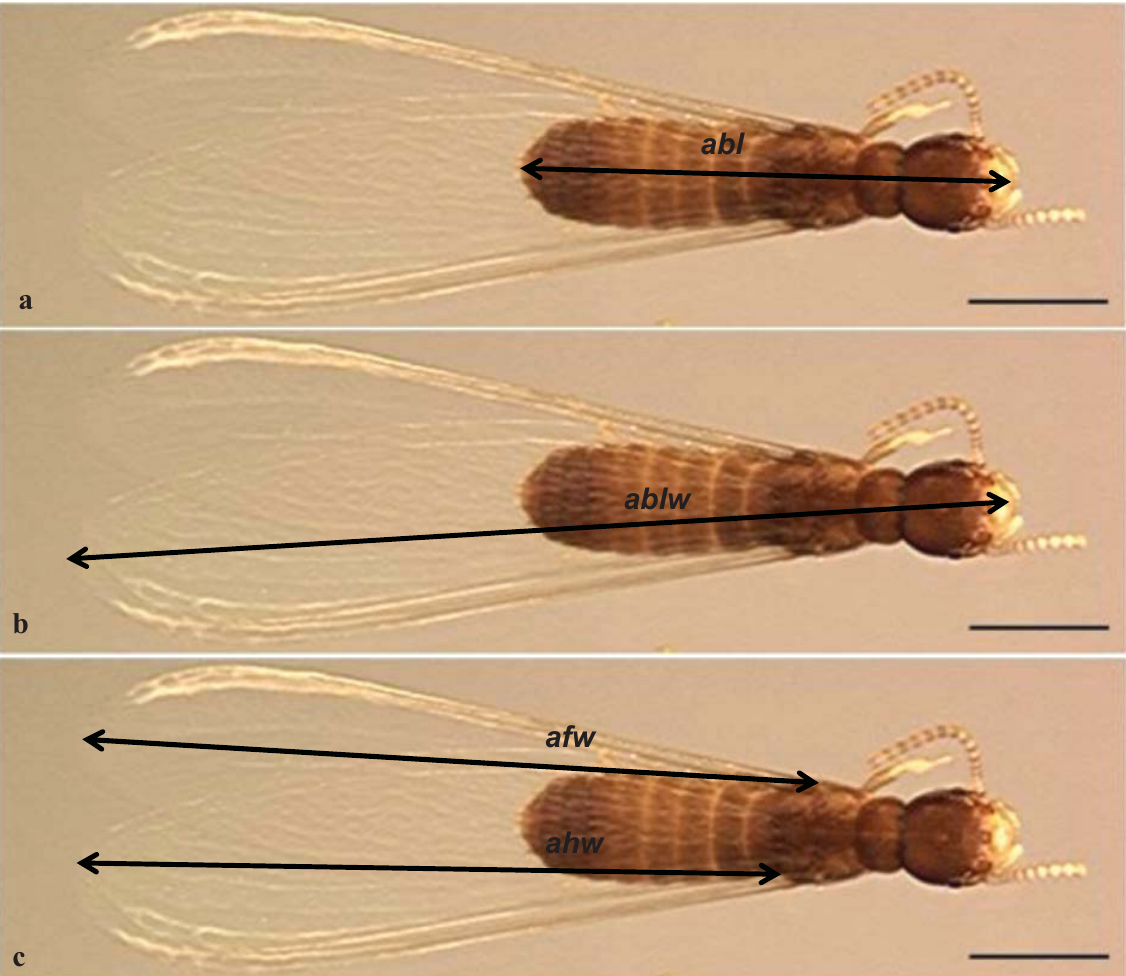
Figure 3. Standard measurements for alate characters: length of body only ( abl ) body-wing ( ablw ), wings ( afw and ahw ) measuremements. Scale bar = 1.0 mm.